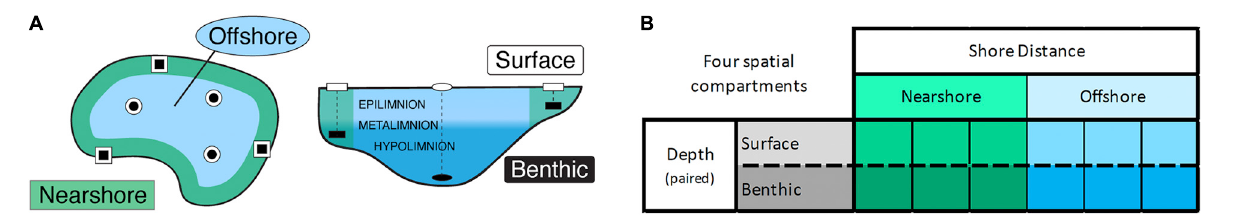
FIGURE 2 | Summary of sampling design for the six lakes in this study. Twelve samples were collected per lake based on depth and distance from shore to define four qualitative sample categories, herein termed compartments. (A) Generalized lake schematic showing nearshore and offshore zones (green and blue, respectively), and surface vs. benthic samples with respect to the metalimnion (see Table 1 ). (B) Table showing the same division of samples into three nearshore locations and three offshore locations, with a surface and a benthic sample taken at each location. The dashed line indicates that samples are paired vertically but not